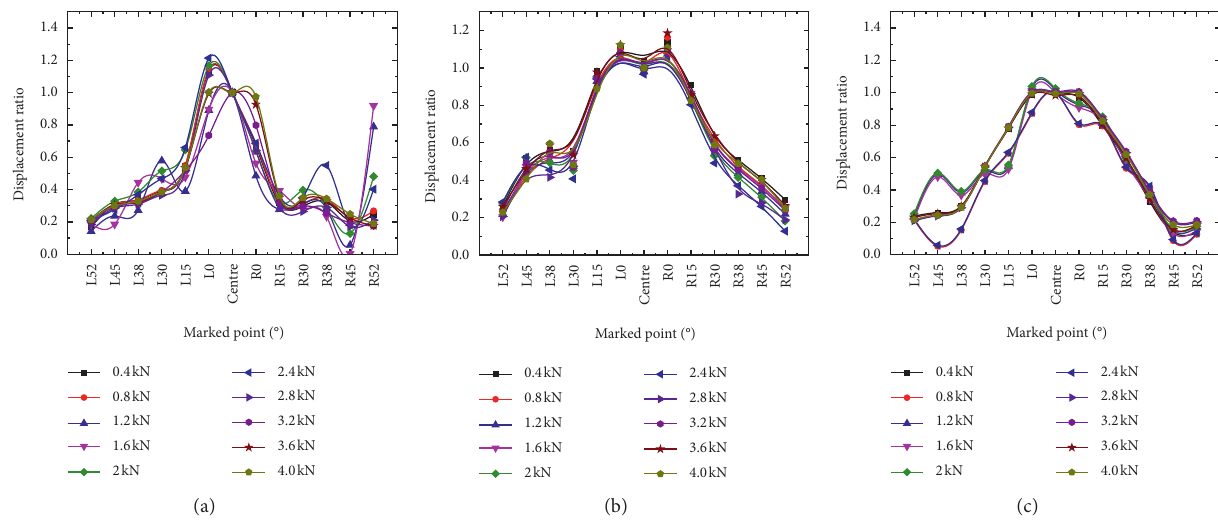
Figure 18: Distribution curve of soil displacement according to diffusion angle under different loads at 45 ° . (a) The 0 b row. (b) The 0.75 b row. (c) The 1.50 b